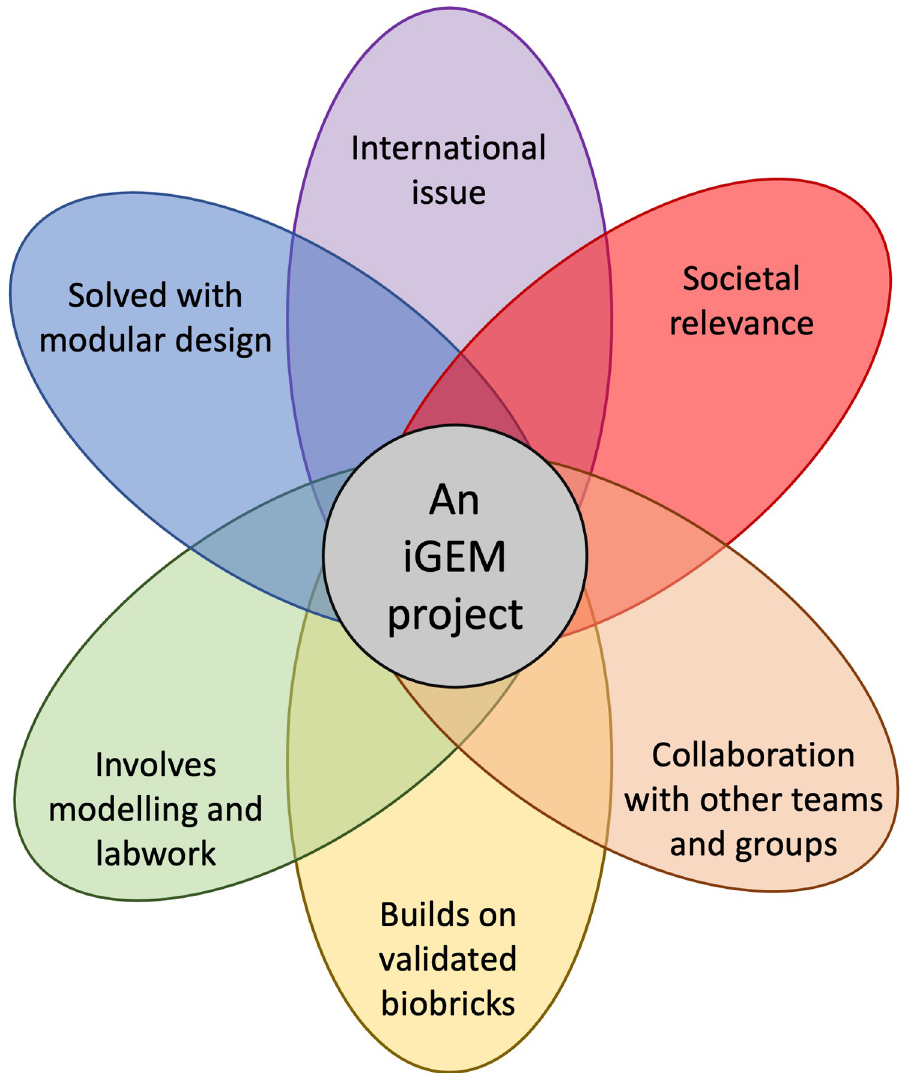
Fig 3. The 6 tenets of our ideal iGEM project. The project should aim to tackle an international problem that can involve local stakeholders. The project should be modular in design such that students can “own” individual subprojects, and should allow for a seamless interaction between experimental and computational biology. By building the project on already available iGEM materials, the project can then allow for easy collaboration with other teams and further develop the iGEM foundation’s parts repository. iGEM, international Genetically Engineered